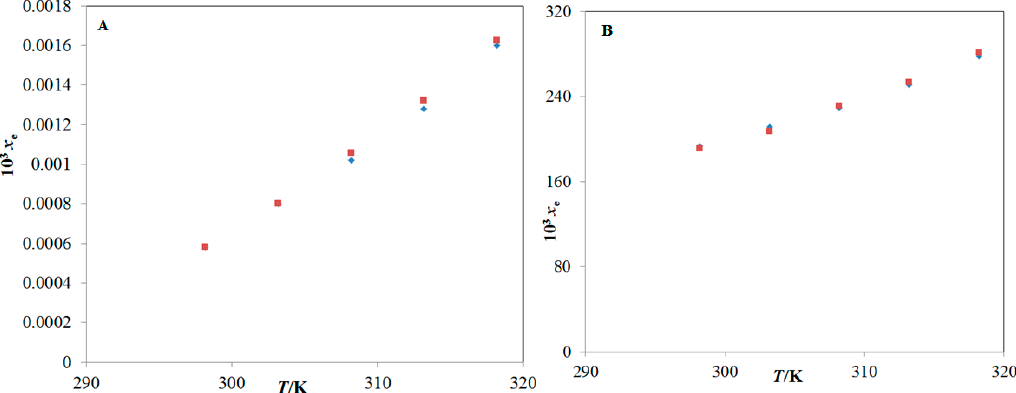
Figure 2. Graphical comparison of FFA solubility in ( A ) pure water and ( B ) pure Carbitol with reported values at T = 298.2–318.2 K. The symbol represents the experimental solubilities of FFA in ( A ) pure water and ( B ) pure Carbitol, and the symbol represents the reported solubilities of FFA in ( A ) pure water and ( B ) pure Carbitol taken from reference [4].